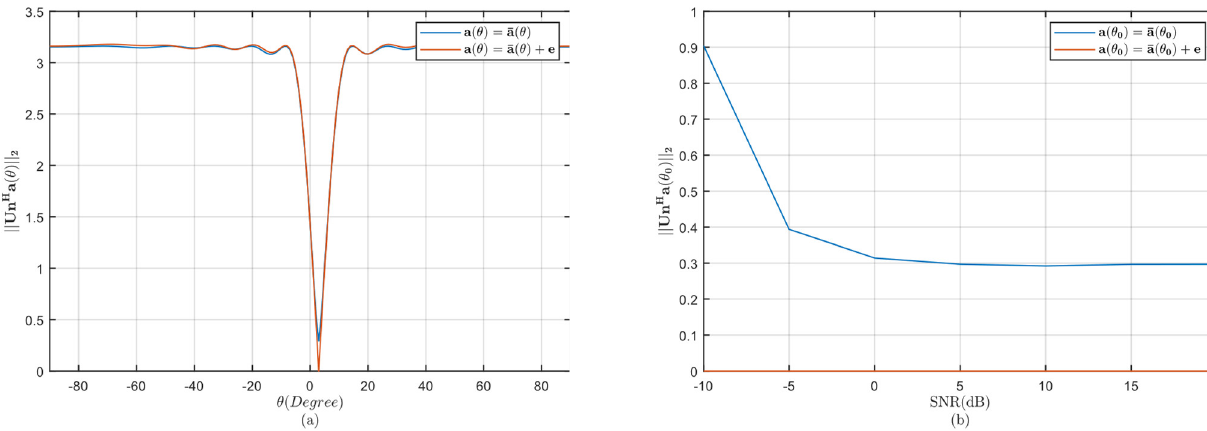
Figure 1. Comparison of ( a ) (cid:107) U H n a ( θ ) (cid:107) ( b ) (cid:107) U H n a ( θ 0 ) (cid:107) versus incident signal 2